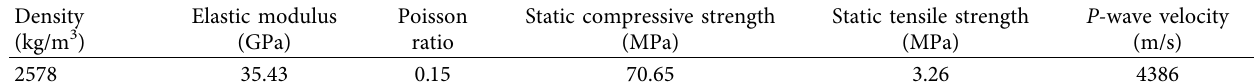
Table 1: Parameters of granite.